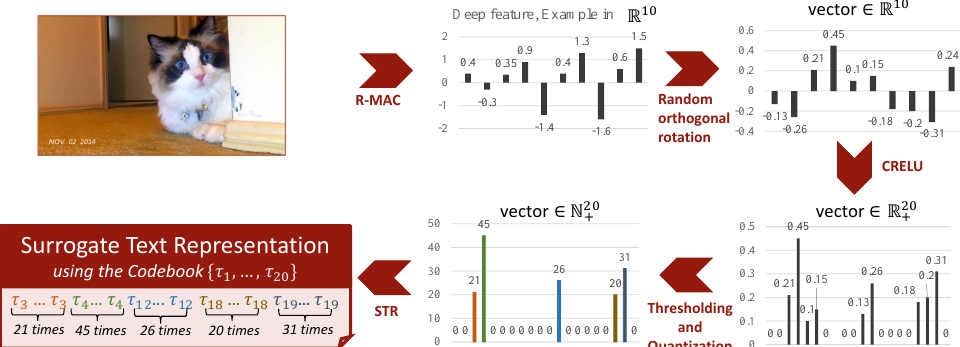
Figure 8. Scalar Quantization-based Surrogate Text representation: clockwise the transformation of the image R-MAC descriptor- depicted as a 10-dimensional vector- into a textual encoding called Surrogate Text